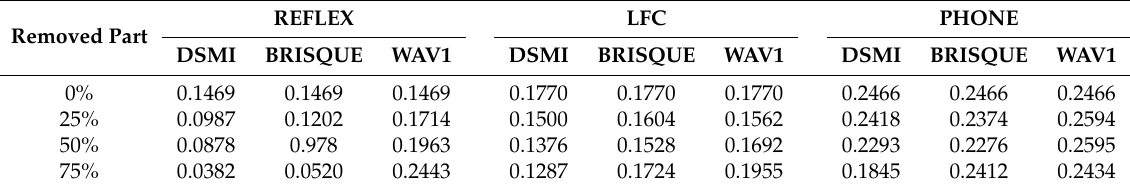
Table 3. The equal error rate (EER) values are calculated after filtering different parts of the iris images with the poorest quality from each test dataset. This table shows the EER values when all iris images are passed to the iris recognition system and after filtering out one quarter, half, and three quarters of the iris images with the poorest quality from the REFLEX, LFC, and PHONE datasets using the DSMI, BRISQUE, and WAV1 quality